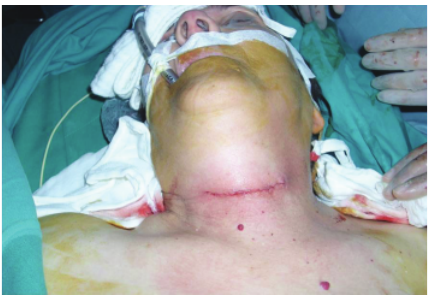
Figure 1: Postoperative patient in group